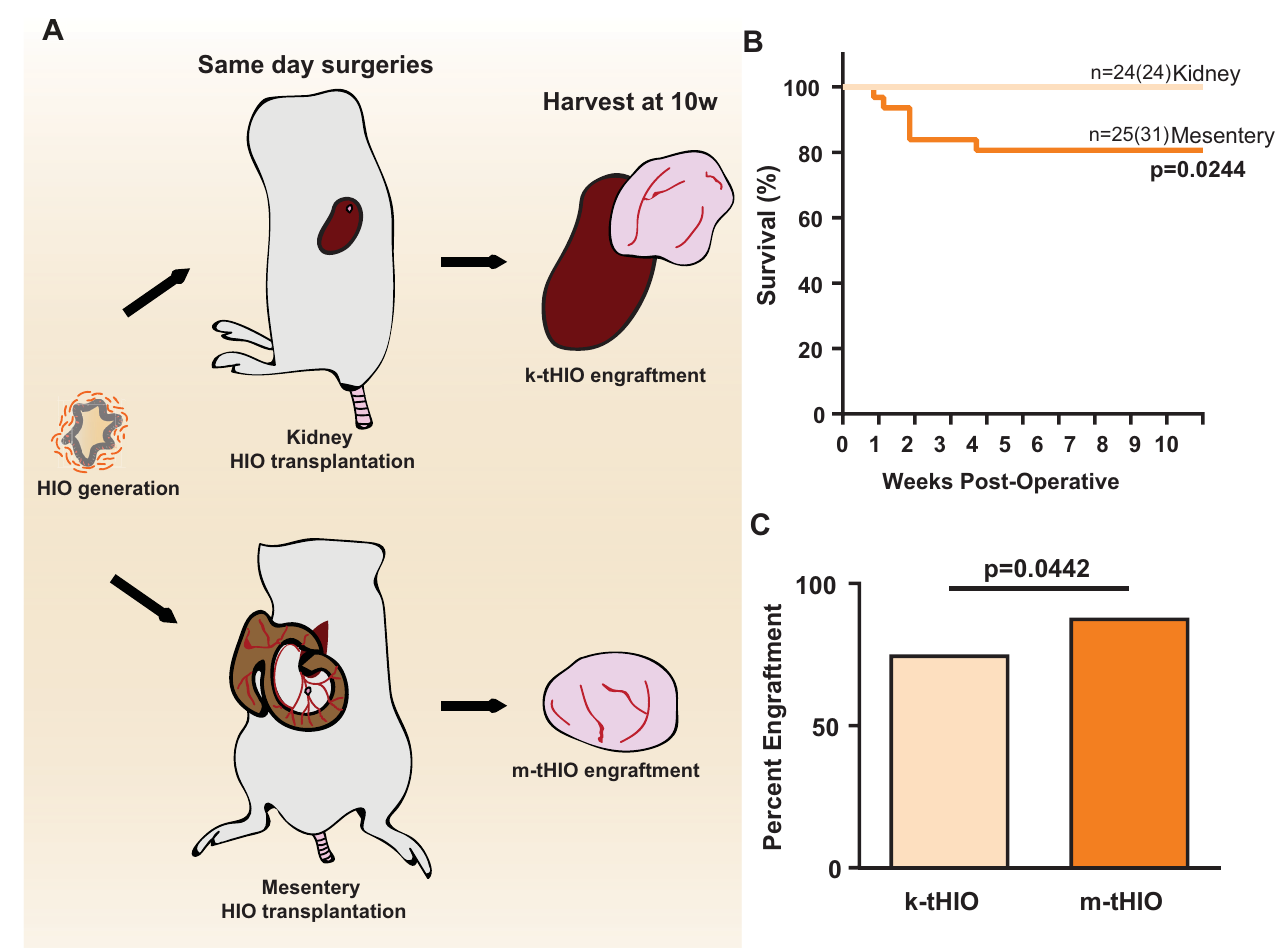
Fig 1. Transplantation into the RSS results in greater survival, but lower engraftment rates than the mesentery. (A) Experimental design schematic. (B) Kaplan-Meier curve associated with kidney and mesentery transplantation procedures (n = 24/24 and n = 25/31 respectively, p = 0.224). (C) Bar graph of engraftment rates at both transplantation sites (n = 17/24 and n = 22/25 respectively, p = 0.0442).